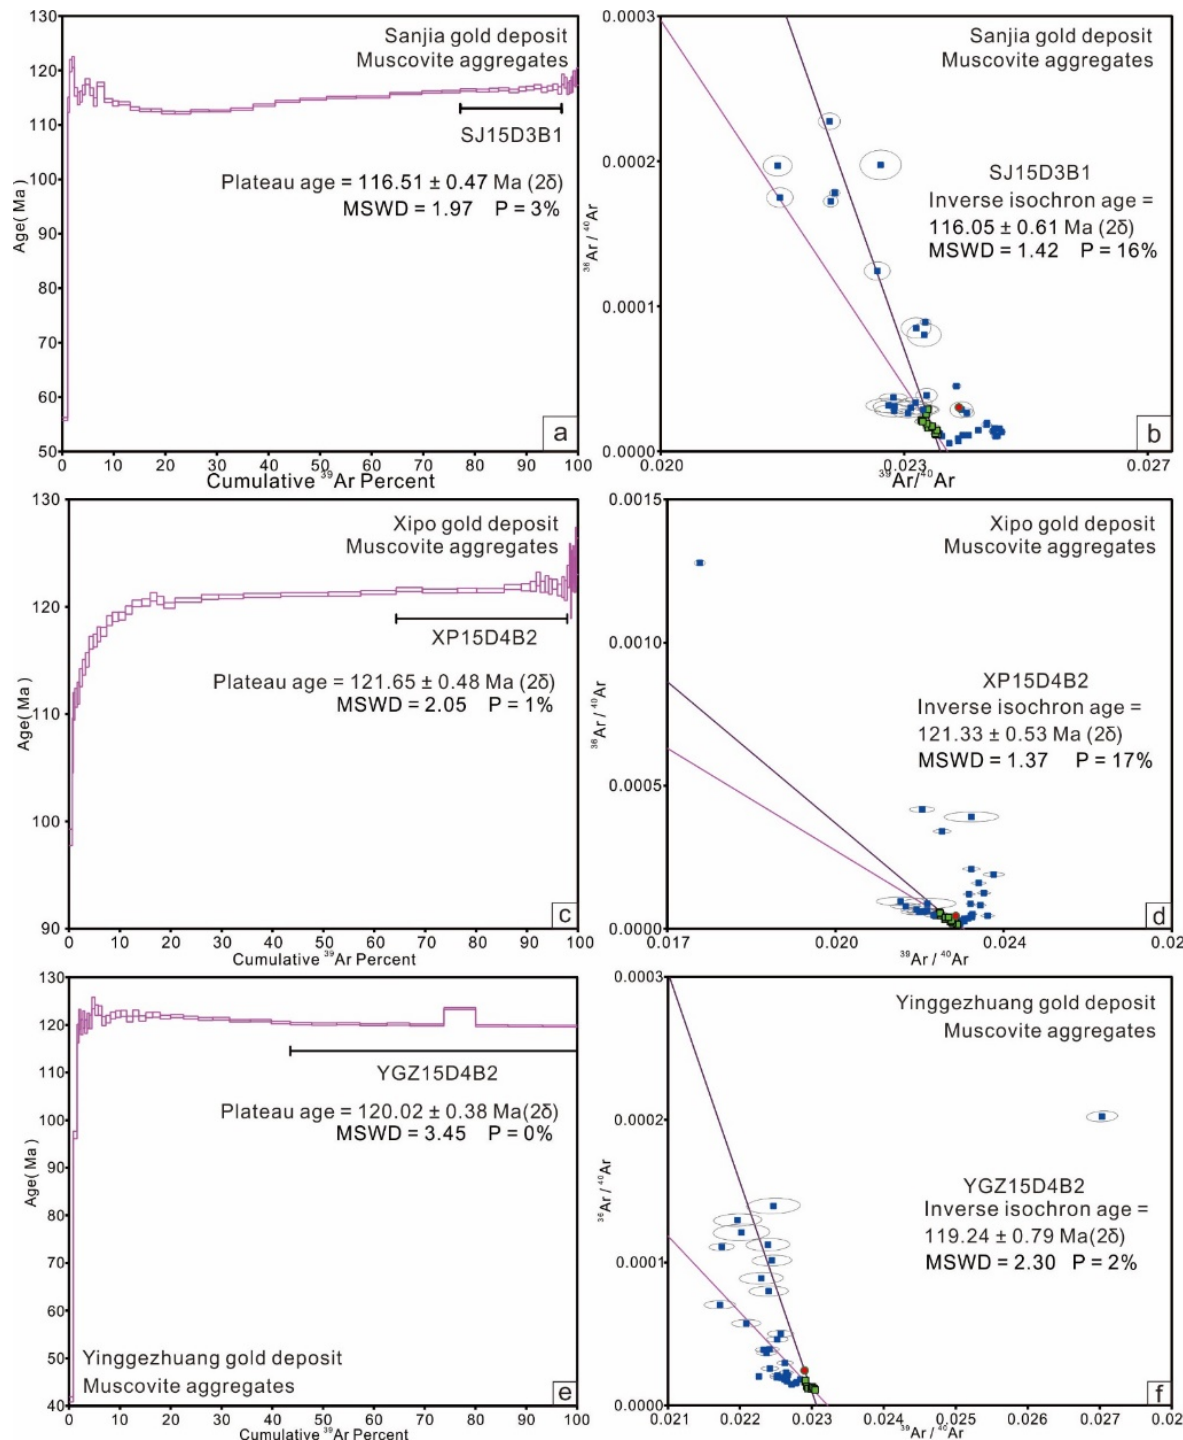
Figure 5. 40 Ar/ 39 Ar plateau ages (2 σ ) and the inverse isochron ages of the hydrothermal muscovite obtained from the Sanjia, Xipo, and Yinggezhuang gold deposits: ( a ) plateau age of the Sanjia gold deposit, ( b ) inverse isochron age of the Sanjia gold deposit, ( c ) plateau age of the Xipo gold deposit, ( d ) inverse isochron age of the Xipo gold deposit, ( e ) plateau age of the Yinggezhuang gold deposit, and ( f ) inverse isochron age of the Yinggezhuang gold deposit. The black line means the atmospheric argon, and the purple line means the trapped argon in ( b , d , f